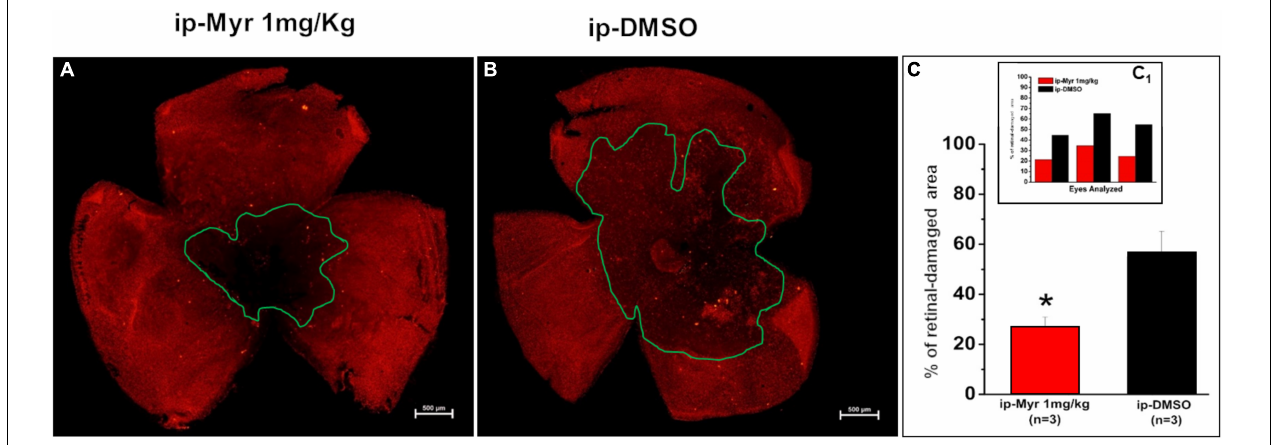
FIGURE 4 | Reduction of the photoreceptor-degeneration area after i.p. administration of Myriocin. (A,B) Representative images of retinal whole mounts obtained from control and Myriocin-treated mice obtained by anti-cone arrestin immunostaining (red fluorescence). The green lines surround the area affected upon the induction of the mutation by light exposure. (C) Quantification of the affected area calculated as a percentage of the total retinal area from three different experiments (shown in the insert bar graph, C1 ), showing a significant reduction in animals treated with Myriocin (red bars) compared to animals treated with vehicle (black bars). The values reported in the main bar graph represent global averages of all the experiments; Values are shown as mean ± SEM ( n = 3, for each analyzed group); * p ≤ 0.05.